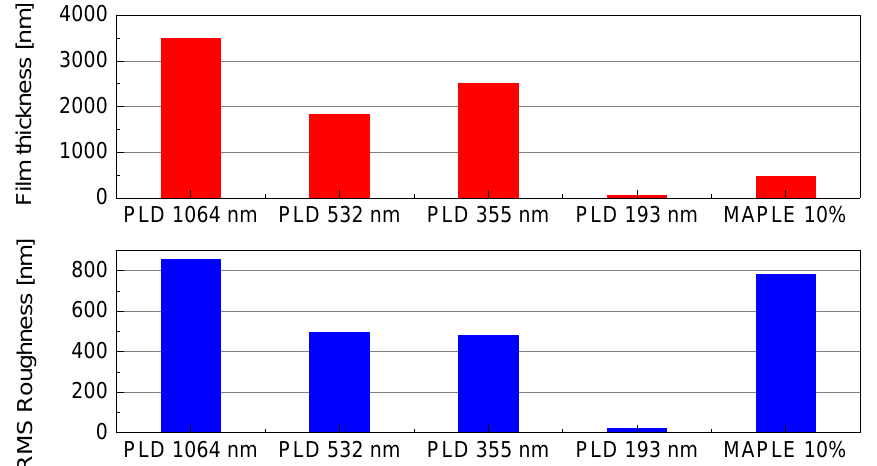
Figure 7. RMS roughness and thickness of films deposited by MAPLE and PLD.